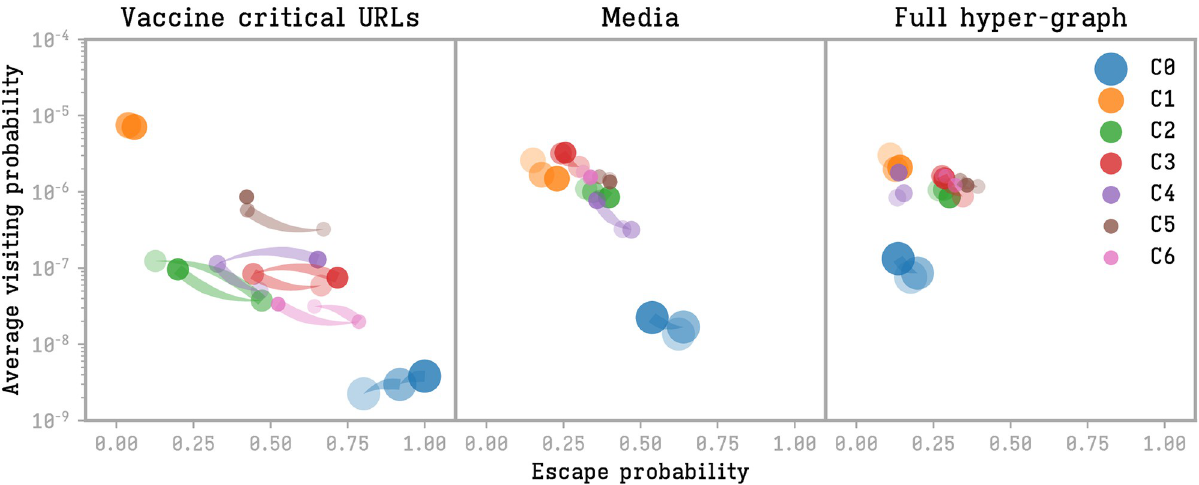
Fig 7. Escape probability and (average) visit probability changes in the three detected periods. Community size is proportional to its number of users. Only the larger communities are reported for the sake of the figure